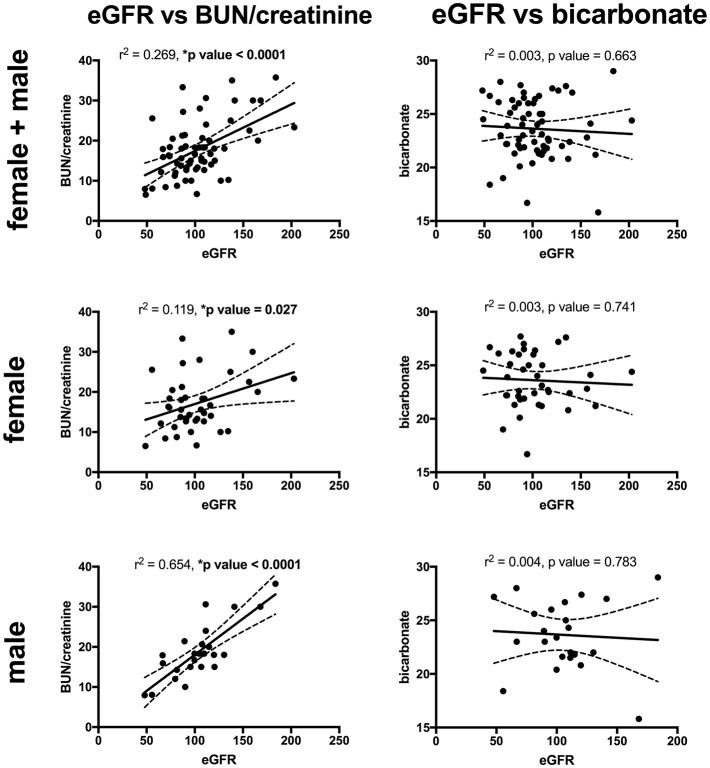
The correlations between eGFR with serum BUN/creatinine ratio (left) and serum bicarbonate (mEq/L) (right), for all patients (top), females (middle), and males (bottom). eGFR had a significant direct correlation with the BUN/creatinine ratio for all patients, females, and males. There was no significant correlation between the eGFR and serum bicarbonate. Sixty-five patients (41 males and 24 females) had both a height z-score and serum BUN/creatinine ratio measured and 63 patients (40 females and 23 males) had both an eGFR and serum bicarbonate. Serum BUN/creatinine in mg/mg, eGFR in mil/min/1.73 m2 and bicarbonate in mEq/L. The dashed lines represent 95% confidence intervals.